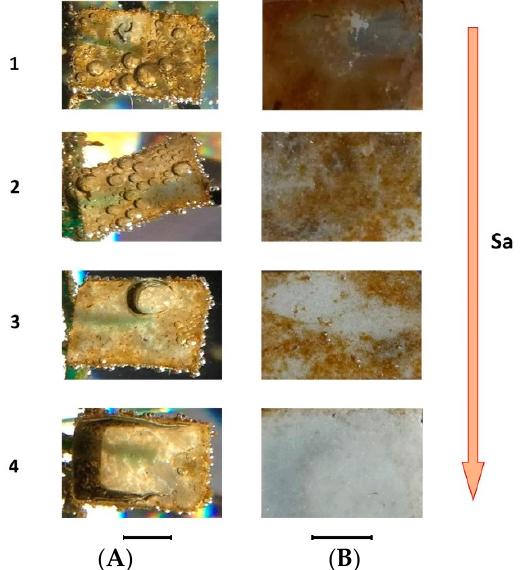
Figure 7. Superhydrophobic samples of session 2 during immersion ( A ) and after extraction ( B ). Scale